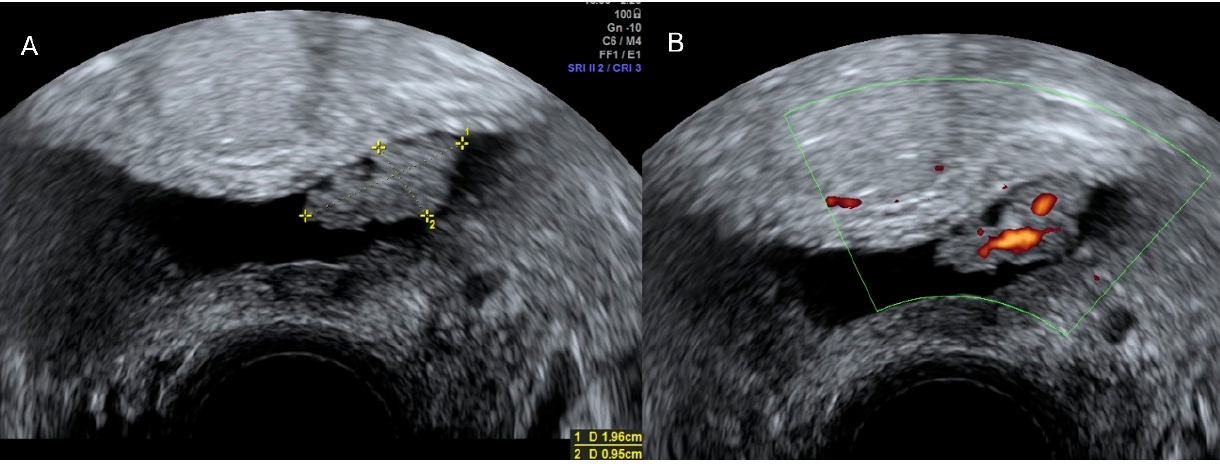
Figure 15. Transvaginal ultrasound shows the urinary bladder with an irregular solid, and polypoid intravesical lesion between the calipers ( A ). Power Doppler reveals high vascularization ( B ). Histology confirmed a bladder carcinoma.